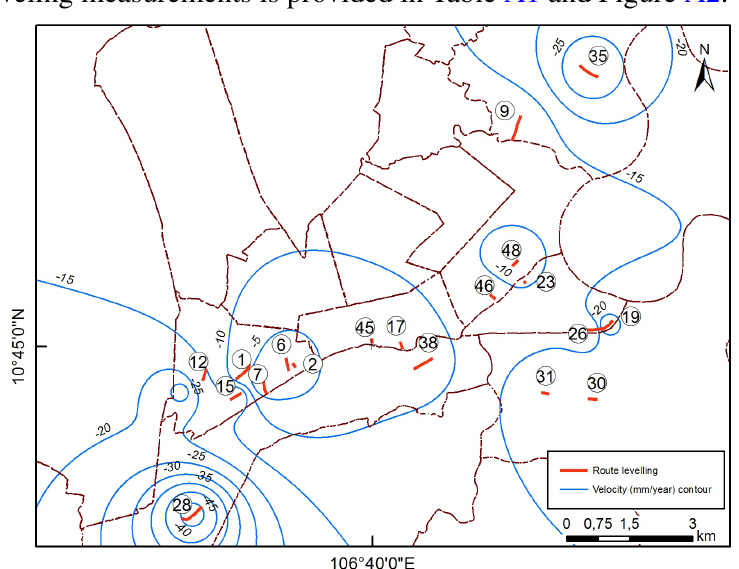
Figure A2. A zoom version of Figure 2a for leveling data. This was interpolated as contour lines to facilitate visualization of the leveling